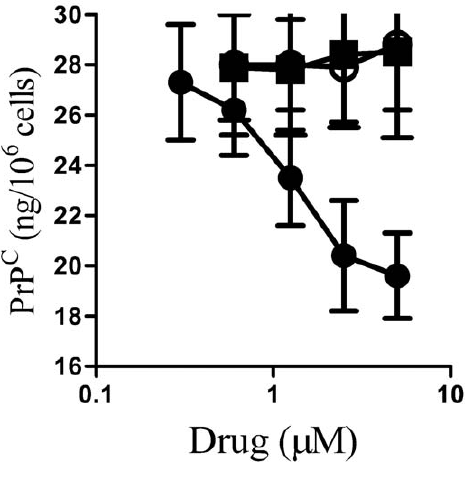
Figure 1. Glimepiride reduced neuronal PrP C expression. The amount of PrP C in whole cell extracts from primary cortical neurones treated for 1 hour with different concentrations of glimepiride ( glibenclamide ( # ) or glipizide ( & ) as shown. Values shown are the mean average amount of PrP C in neuronal extracts (ng/10 6 cells) 6 SD,